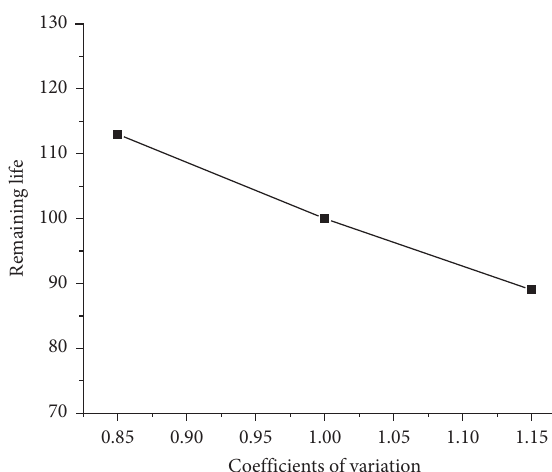
Figure 7: Influence of mean value of live load.